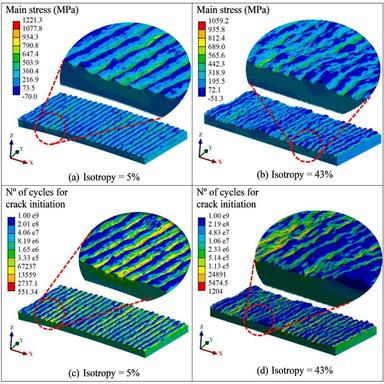
Numerical simulation of fatigue tests: main stress results for surface isotropy of (a) 5 % and (b) 43 % and number of fatigue cycles for surface isotropy of (c) 5 % and (d) 43 %.